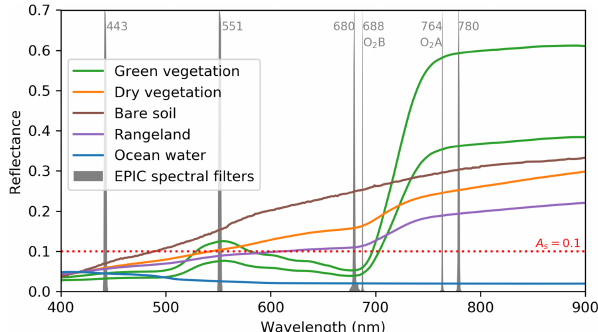
Figure 4. Surface reflectance spectra (from the ASTER spectral li- brary; Baldridge et al., 2009) for various surface types in the visible to NIR range, with selected EPIC spectral bands within this range shown in